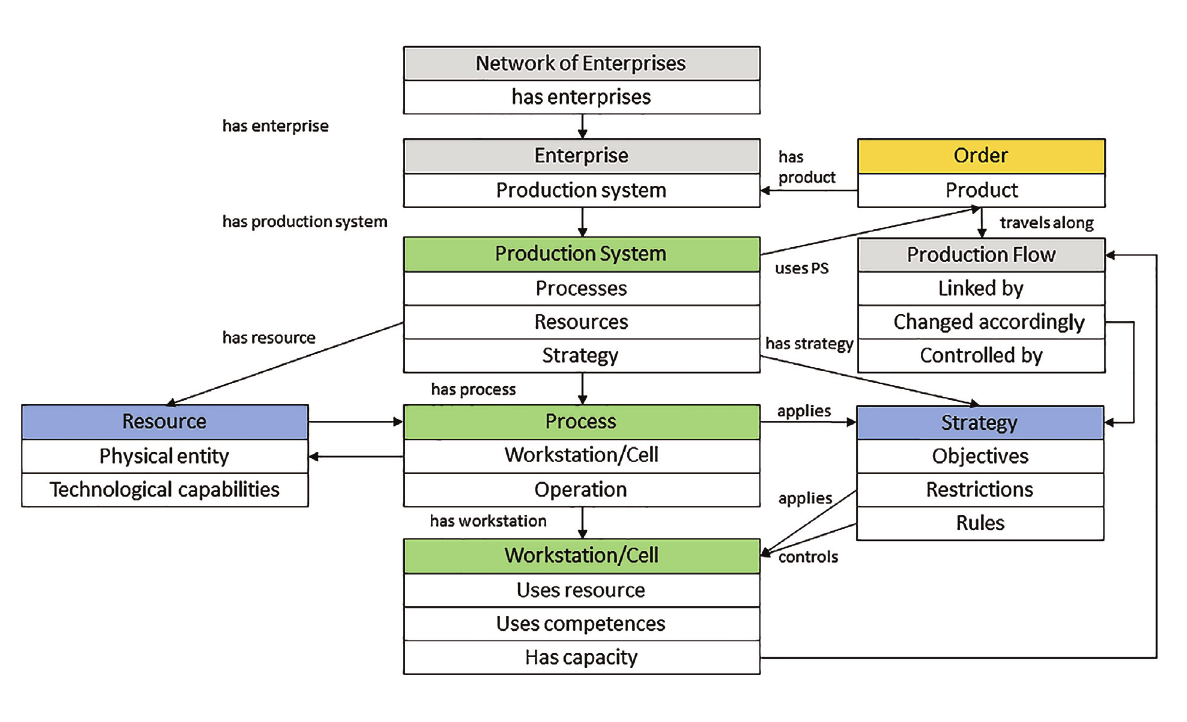
Fig. 1. Ontology in manufacturing [4]. PS − Production